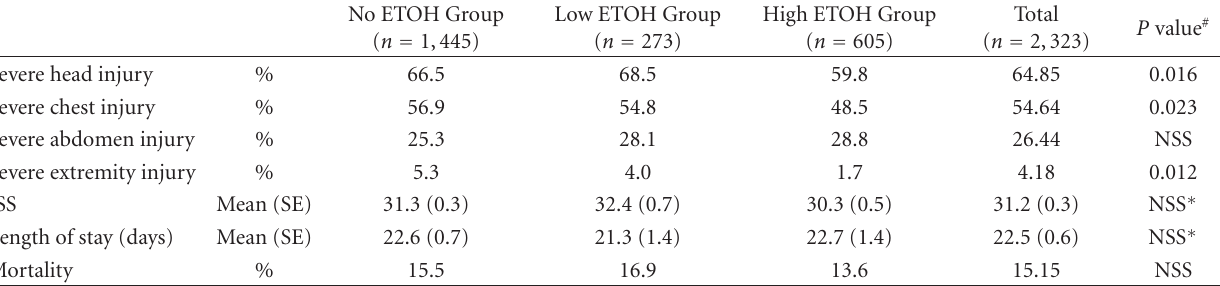
Table 2: Clinical characteristics of